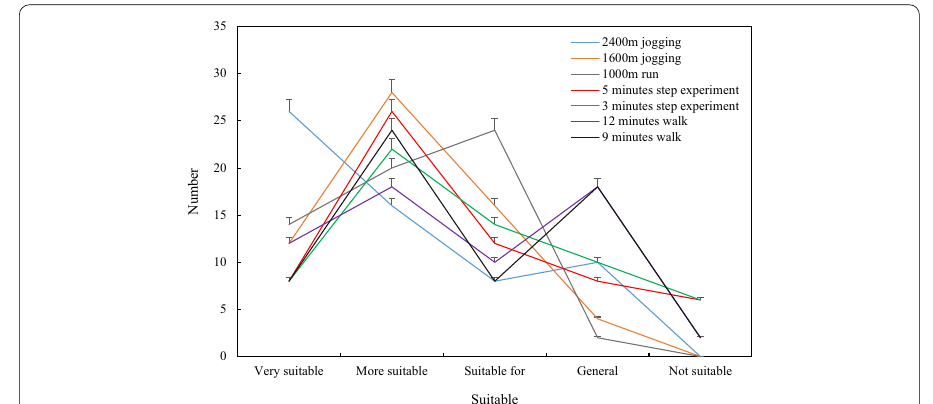
Fig. 5 Operability survey results of the physical fitness “cardiopulmonary endurance test project”